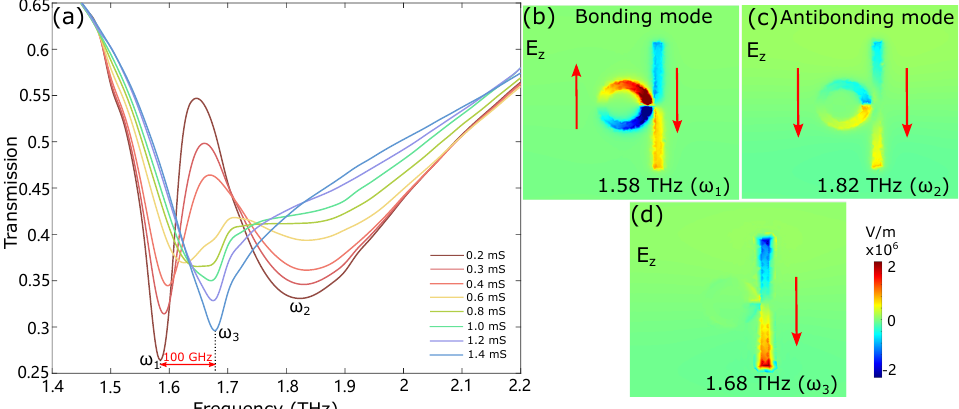
Figure 3. ( a ) Transmission spectra of the metal–graphene device for different DC graphene conductiv- ities. With the increase in the graphene conductivity from 0.2 mS to 1.4 mS, the resonance frequency is tuned from 1.58 THz ( ω 1 ) to 1.68 THz ( ω 3 ), with a frequency tuning range of 100 GHz. ( b , c ) The electric field E z distribution of the coupled device at two transmission dips at frequency of 1.58 THz ( ω 1 ) and 1.82 THz ( ω 2 ). The different induced current directions in the two resonators illustrate that the low-energy mode is bonding mode while the high-energy mode is the antibonding mode of the coupled structure. ( d ) The electric field E z distribution of the coupled device is 1.68 THz when the conductivity of graphene is set at 1.4 mS. Only the bright resonator shows strong localized surface plasmon resonance, while the resonance of the dark resonator is much